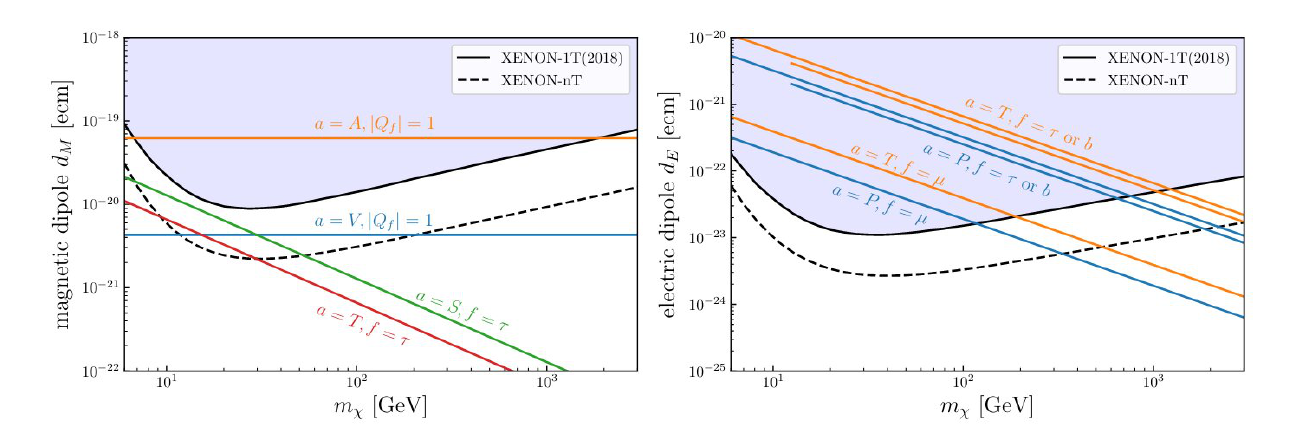
Figure 26: Direct detection constraints on dark magnetic dipole moments (left) and electric dipole moments (right), from Ref. [ 141 ]